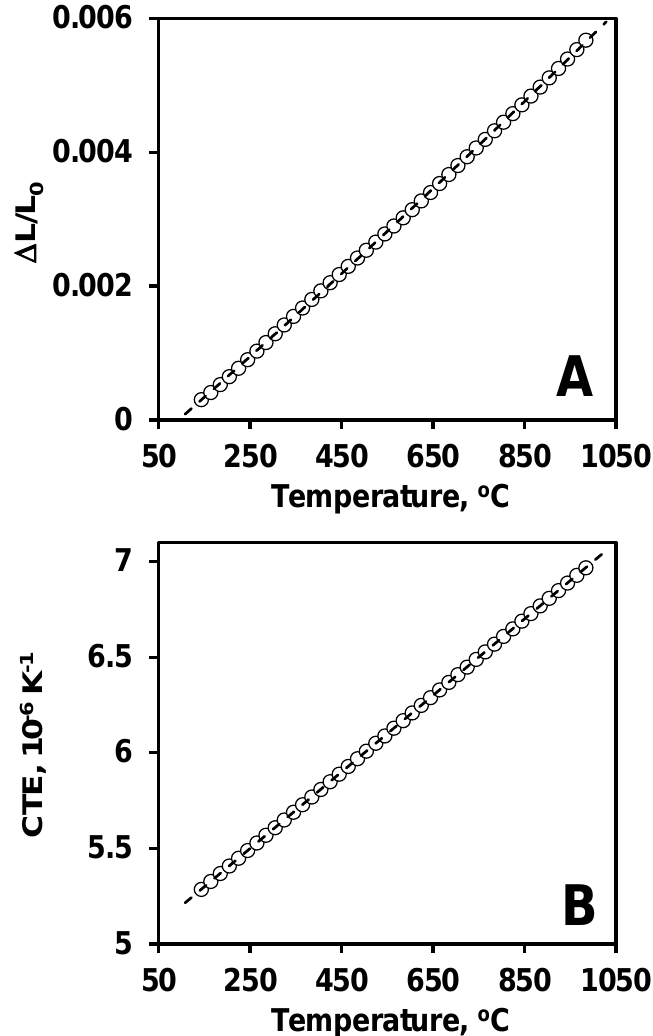
Figure 4. ( A ) Thermal expansion and ( B ) coefficient of thermal expansion of B 4 C as a function of temperature.